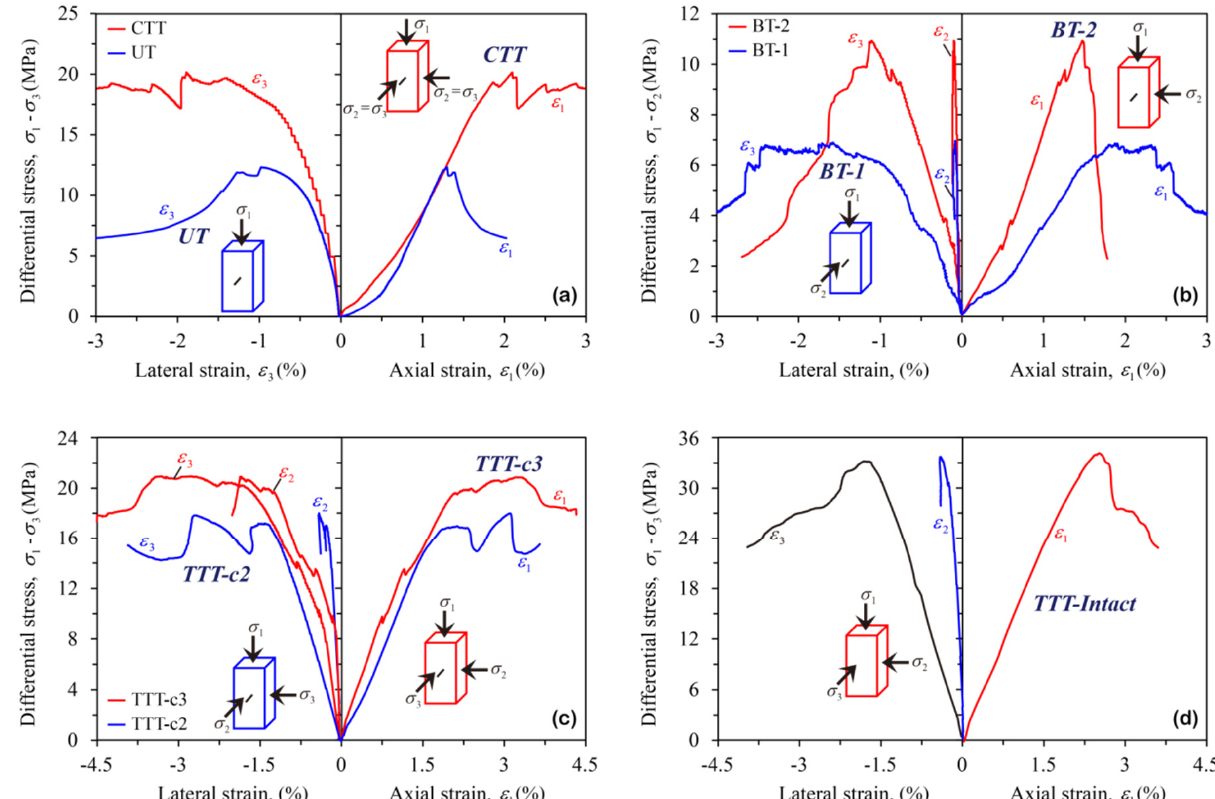
Figure 4. Comparison of typical stress–strain curves of the rock under different test schemes: ( a ) UT vs. CTT; ( b ) BT − 1 vs. BT − 2; ( c ) TTT − c2 vs. TTT − c3; ( d ) TTT − Intact. ( a ) UT vs. CTT; ( b ) BT-1 vs. BT-2; ( c ) TTT-c2 vs. TTT-c3; ( d )